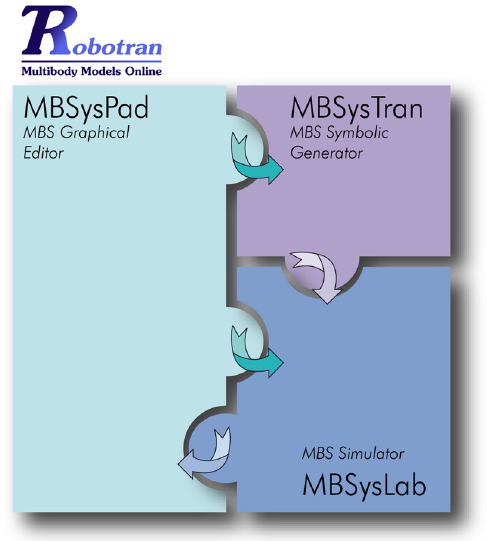
Figure 11. Illustration of the programs composing the ROBO- TRAN